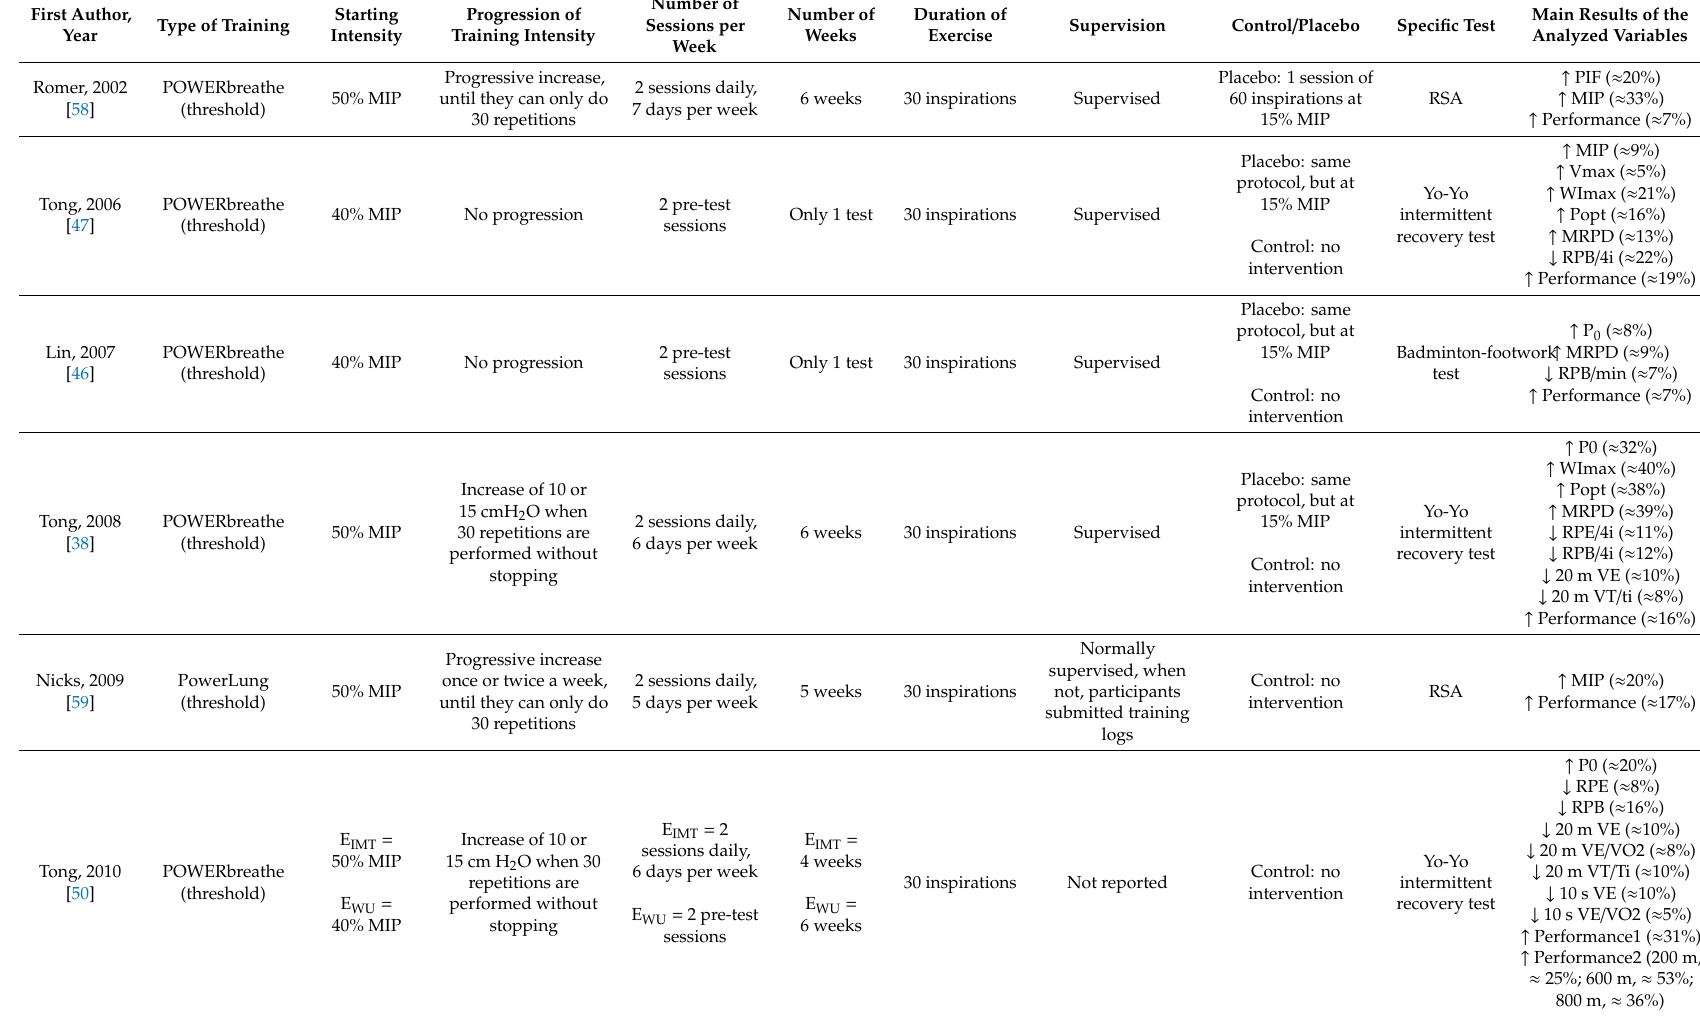
Table 4. Description of the interventions and the